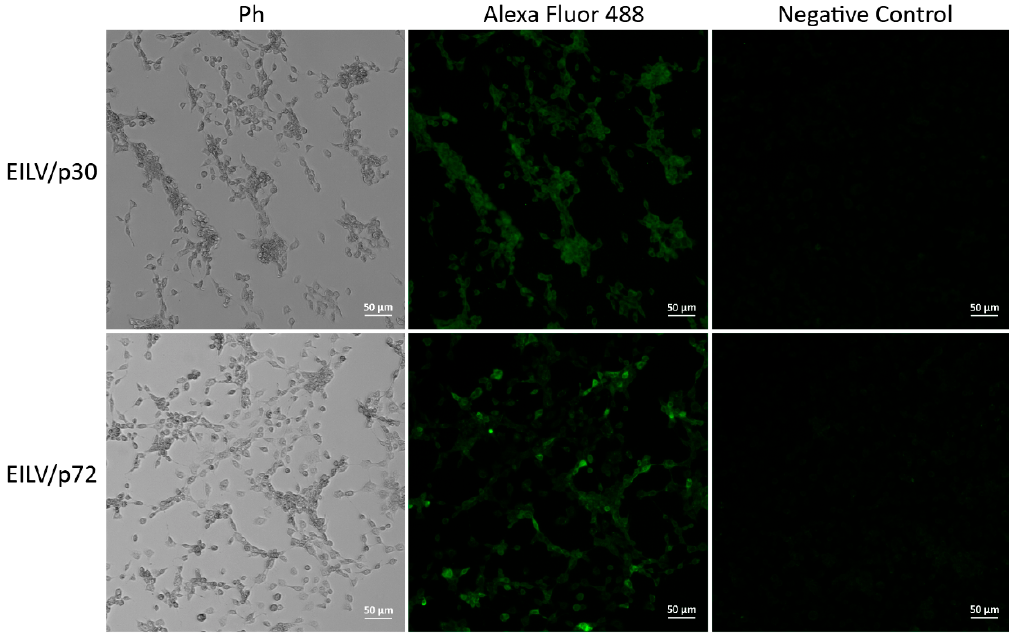
Figure 6. Expression of ASFV p30 and p72 antigens in C7/10 cells infected with EILV/p30 and EILV/p72 recombinants. Cells were inoculated with viruses with an MOI of 5. IFA was performed at 24 hpi.